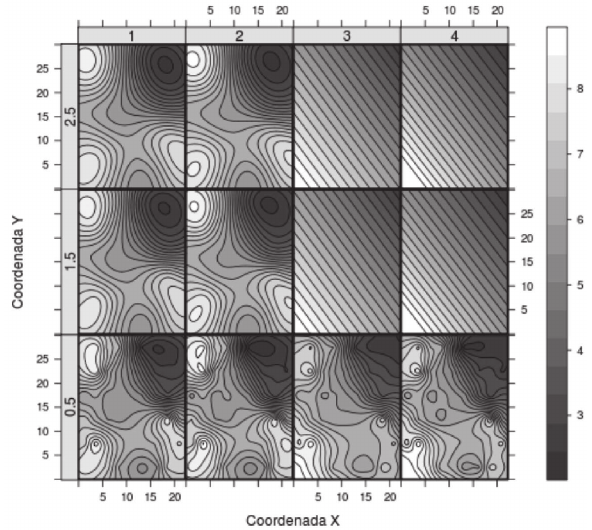
Figura 2. Mapas de teores de fósforo estimados por krigagem em uma malha regular de 10.000 pontos com base em 45 pontos amostrais para diferentes valores do parâmetro de suavidade ( kappa 0,5, 1,5 e 2,5). 1: modelo ajustado aos dados originais; 2: modelo ajustado aos dados transformados; 3: modelo ajustado aos dados originais com covariáveis (coordenadas); e 4: modelo ajustado aos dados transformados com covariáveis